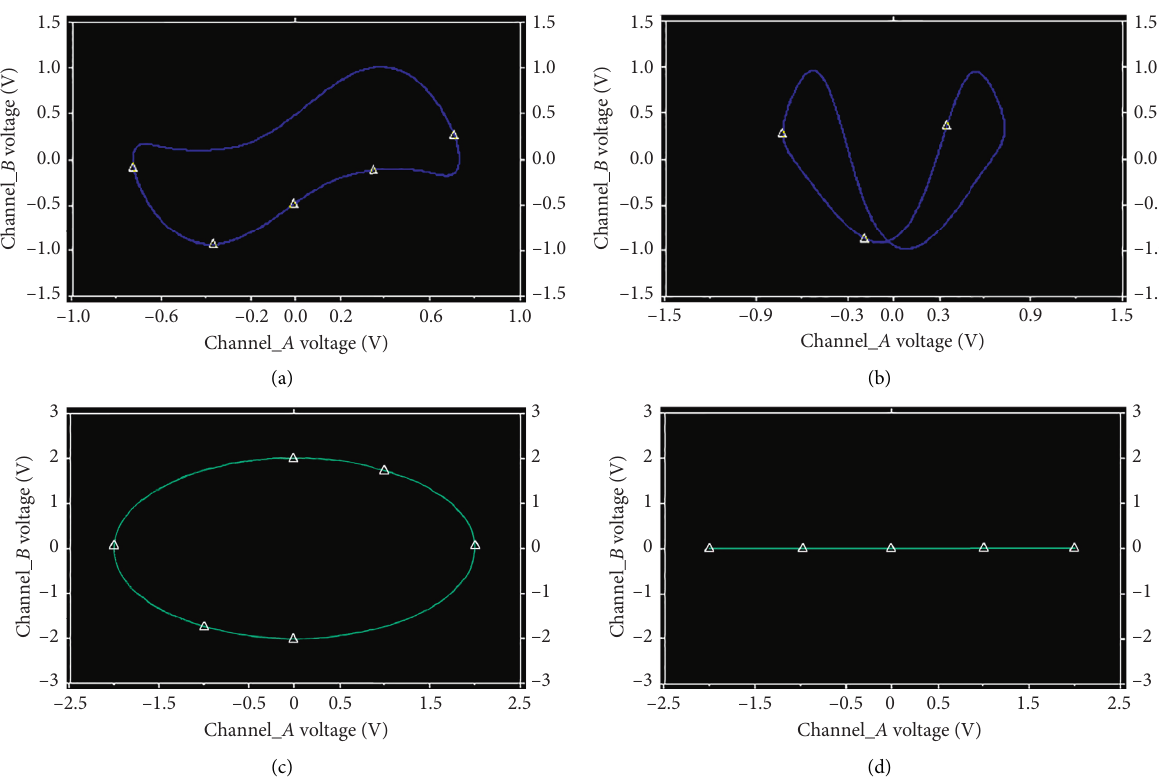
Figure 9: Circuit simulation results of coexisting symmetric chaotic flow for system (1). (a) x − y map. Initial value is (0, 5, 0). (b) x − z map. Initial value is (0, 5, 0). (c) x − y map. Initial value is (0, 2.12, 0). (d) x − z map. Initial value is (0, 2.12, 0).